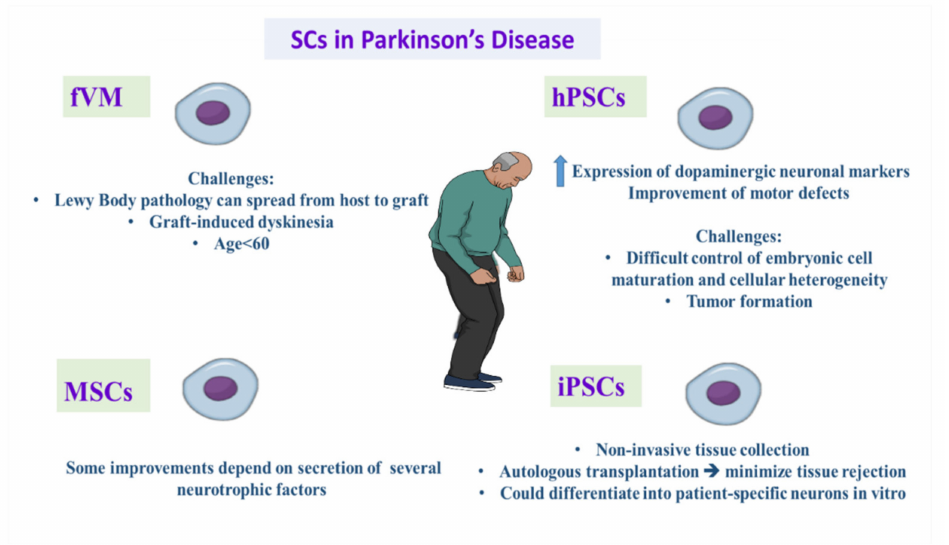
Figure 1. Demonstrating the promising role and challenges of different types of stem cell therapy in treating Parkinson’s disease. iPSCs: induced pluripotent stem cells, hPSCs: human pluripotent stem cells, fVM: fetal ventral mesencephalic tissue, MSCs: mesenchymal stem